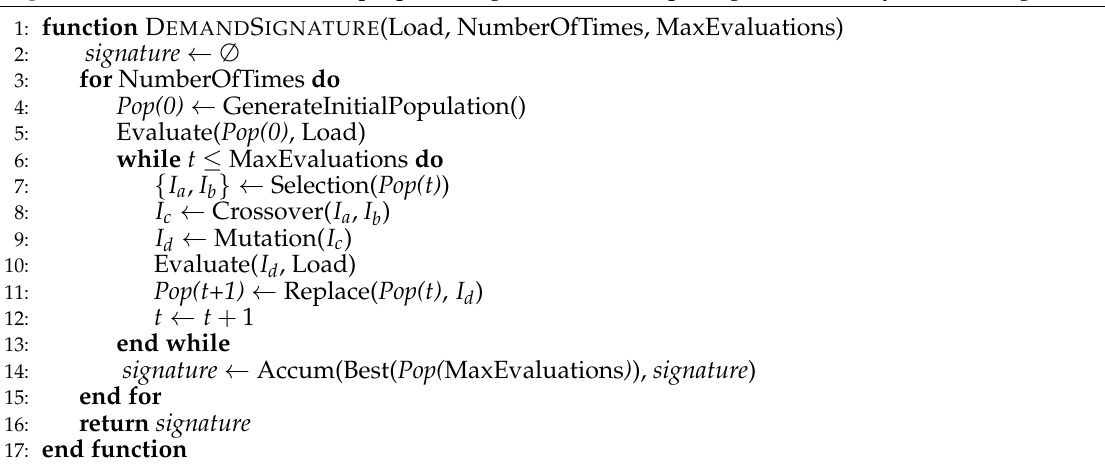
Algorithm 1 Pseudo-code of the proposed algorithm for computing the electricity demand